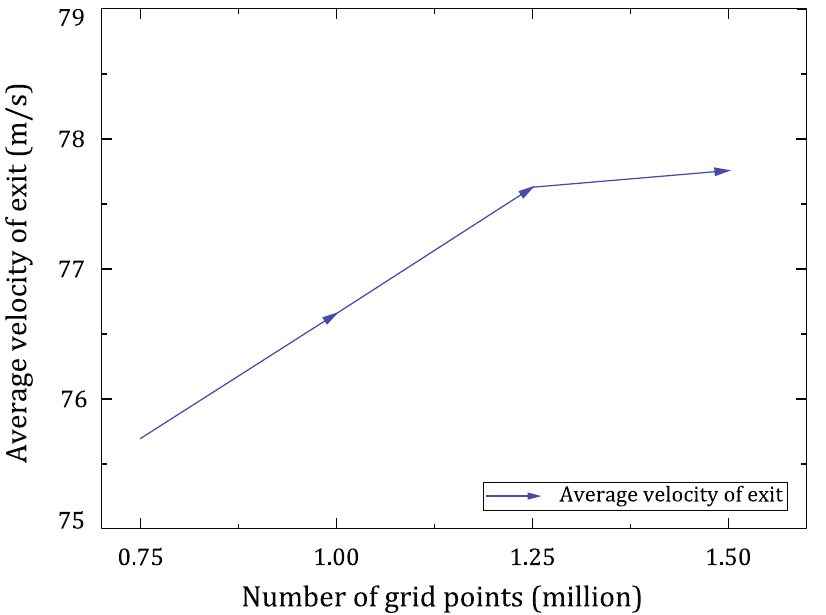
Figure 7: Average exit velocity for di ff erent numbers of grid points.